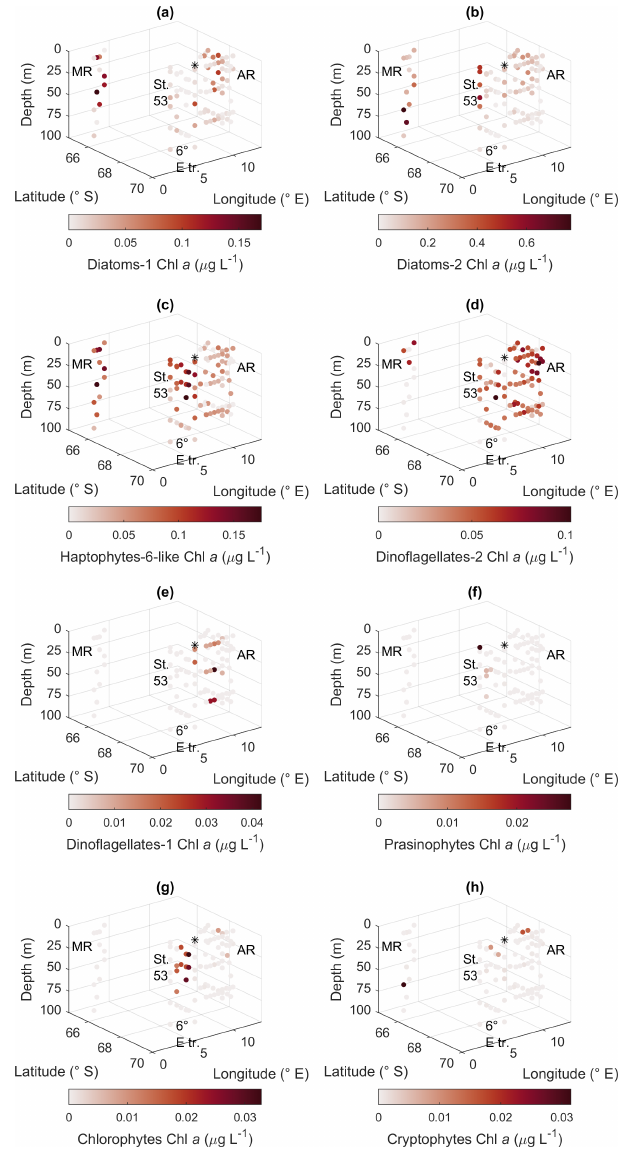
Figure 10. CHEMTAX results for the different algal groups. (a) Di- atom type 1, (b) diatom type 2, (c) haptophyte type 6-like, (d) di- noflagellate type 1, (e) dinoflagellate type 2, (f) prasinophytes, (g) chlorophytes, and (h) cryptophytes. MR: Maud Rise, St. 53: station 53, AR: Astrid Ridge, 6 ◦ E tr.: 6 ◦ E transect. Station 54 is marked with a black